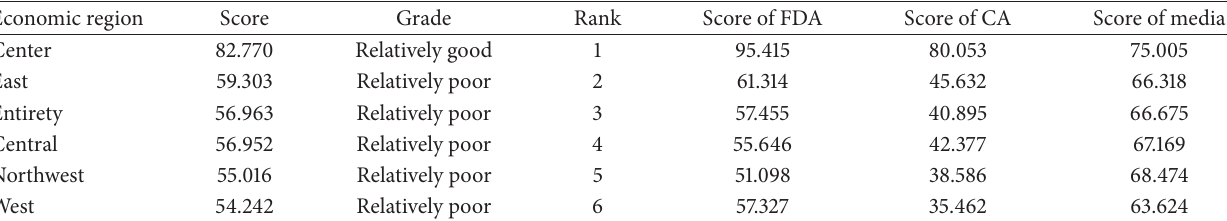
Table 11: Scores of different economic